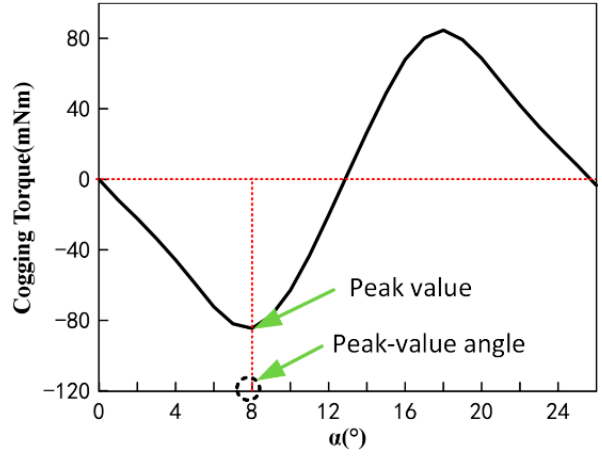
Figure 6. Typical cogging torque